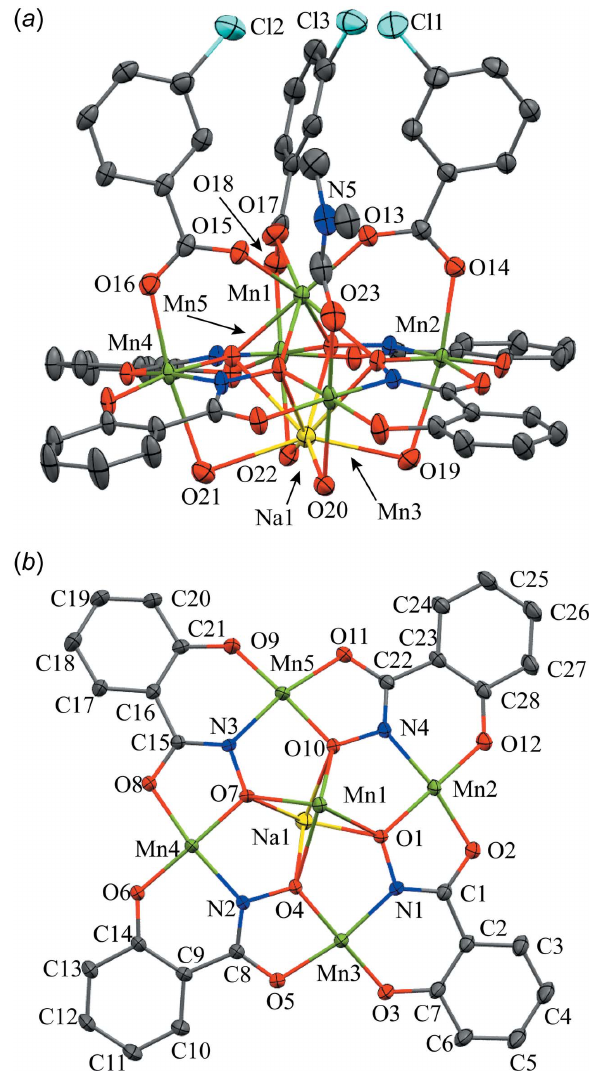
Figure 2 The single-crystal X-ray structure of MnNa(3-chlorobenzoate) 3 [12- MC Mn(III)N(shi) -4](DMF)(H 2 O) 4 (cid:2) 4DMF (cid:2) 0.72H 2 O, 2 , with displacement ellipsoids at the 50% probability level. ( a ) side view with only the metal atoms and heteroatoms of the axial ligands labelled for clarity and ( b ) top view with the axial ligand atoms omitted for clarity. In addition, the lattice DMF molecules, partially occupied water molecule, hydrogen atoms, and disorder have been omitted for clarity. See Fig. 1 for additional display